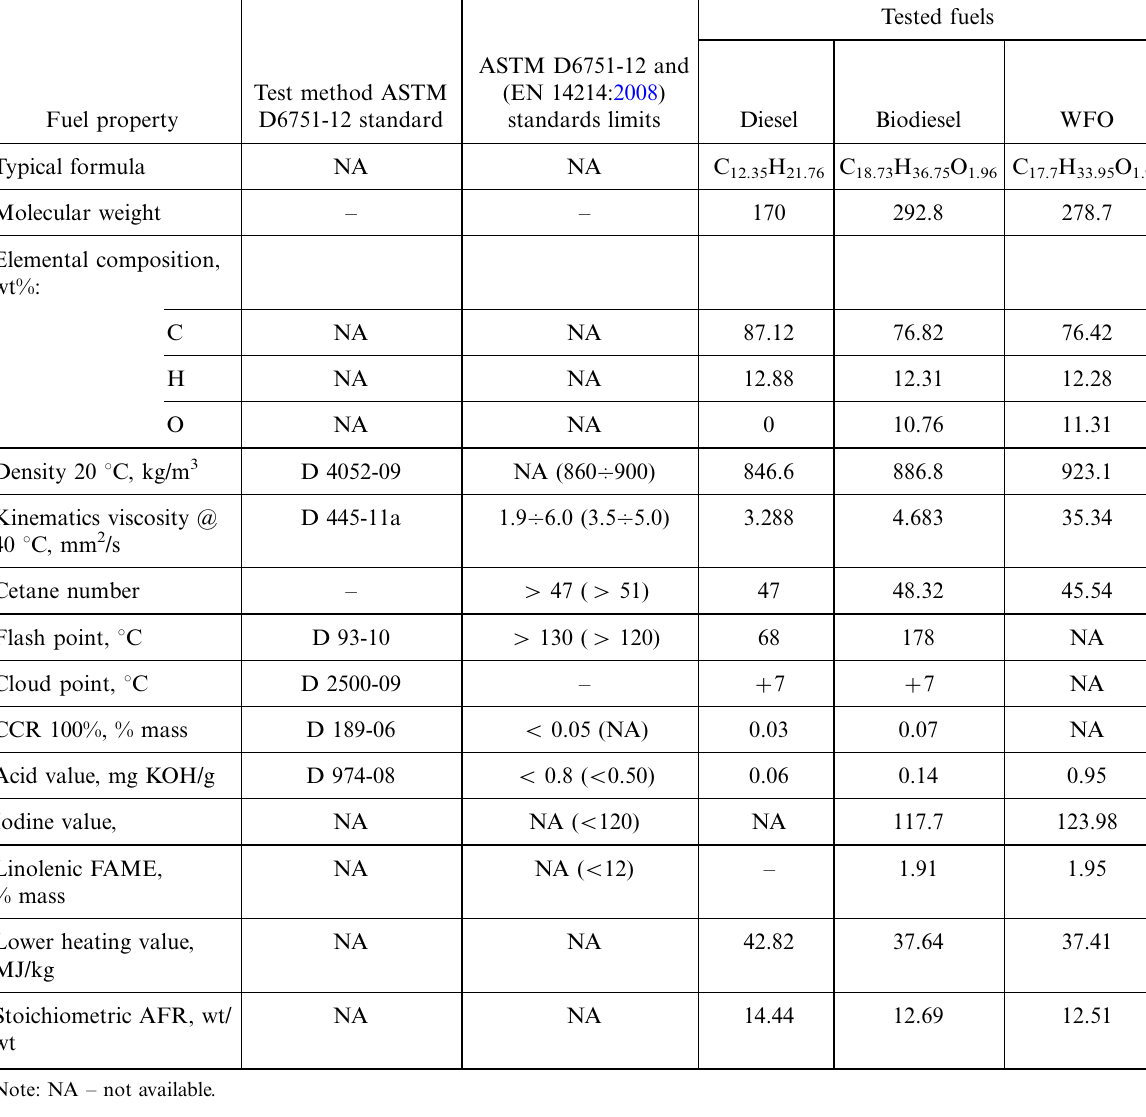
Table 1. Chemical and physical properties of the tested fuels